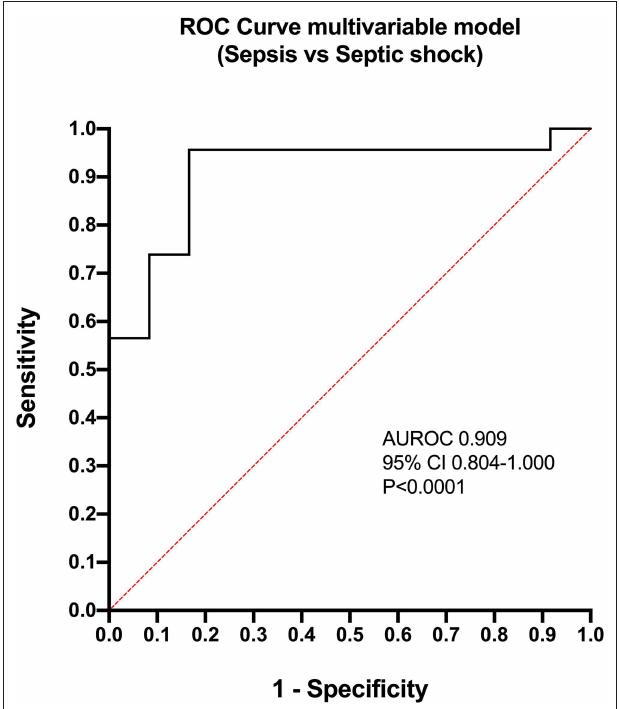
FIGURE 5 | Receiver operating characteristic (ROC) curve for the multivariable model constructed for the differentiation of cats with septic shock from those with sepsis. The model contained three variables: FMS-like tyrosine kinase-3 ligand, Interleukin-12 and MCP-1 monocyte chemoattractant-1. AUROC, area under the ROC curve; CI, confidence interval.